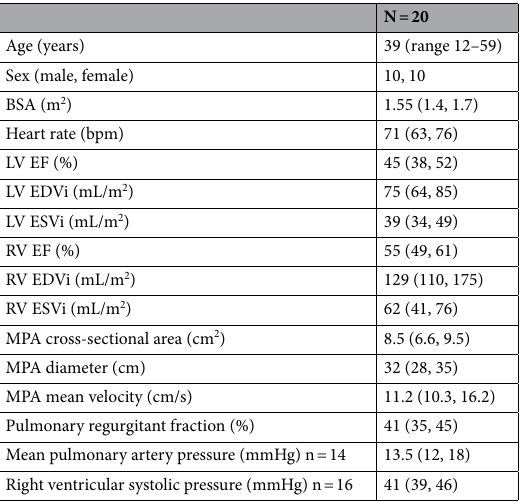
The results of circulation analysis in the MPA are summarized in Table 2. The Max and Integral values for clockwise short-axis vorticity were greater than those for counterclockwise circulation. The time-circulation curves of short-axis circulation in the MPA showed waveforms with 1 or 2 peaks, and the waves of the clockwise circulation and counterclockwise circula- tion were almost parallel. The time-circulation curve of longitudinal circulation showed a single waveform with 1 peak (Fig. 4). Clockwise circulation in the short-axis proximal MPA had significant correlation with RVEDVi (Max ρ = 0.46, p = 0.03; Integral ρ = 0.47, p = 0.04) and RVESVi (Max ρ = 0.49, p = 0.02; Integral ρ = 0.49, p = 0.03; Table 3). The area of the MPA was positively correlated with clockwise (Max ρ = 0.54, p = 0.01; Integral ρ = 0.59, p = 0.006) and counterclockwise circulation in the proximal MPA (Max ρ = 0.66, p = 0.001; Integral ρ = 0.61, p = 0.004; Table 4). The diameter of the MPA was positively correlated with counterclockwise circulation in the proximal MPA (Max ρ = 0.50, p = 0.02; Min ρ = 0.46, p = 0.03; Table 4). Based on partial correlation analysis, after adjust- ment for the MPA area, the correlation between the short-axis proximal MPA and RV measurement was not significant (Table 5). Counterclockwise circulation in the short-axis distal MPA had a significant negative correlation with RVEF (Min ρ = − 0.52; Table 3). The diameter of the MPA was positively correlated with clockwise and counterclockwise Min circulation in the short-axis distal MPA (clockwise ρ = 0.73, p = 0.0002; counterclockwise ρ = 0.65, p = 0.001; Table 4). Partial correlation analysis, after adjustment for the MPA diameter, had a significant correlation between the counterclockwise Min circulation in the short-axis distal MPA and RVEF (Min ρ = − 0.65, p = 0.002; Table 5). The clockwise longitudinal circulation had significant correlations with the RVEF (Max ρ = − 0.76, p = 0.0009; with the Min longitudinal circulation (ρ = 0.54, p = 0.03; Table 4). Partial correlation analysis, after adjustment for MPA area, showed a significant correlation between the clockwise longitudinal circulation and RVEF (Max The correlations between the PRF and circulation, and between the PRF and RV function were not significant. The correlation between the mean velocity of the MPA and the circulation was not significant. The correlations between the mean the pulmonary artery pressure and circulation, and between the RV systolic pressure and circulation were not significant. The sensitivity and specificity of the longitudinal circulation predicting RVEF less than 50% was as follow: Max longitudinal circulation sensitivity = 75%, specificity = 75%, AUC = 0.89, cutoff value = 0.051 m 2 /s; Min longitudinal circulation sensitivity = 75%, specificity = 57%, AUC = 0.82, cutoff value = 0.0059 m 2 /s; Integral